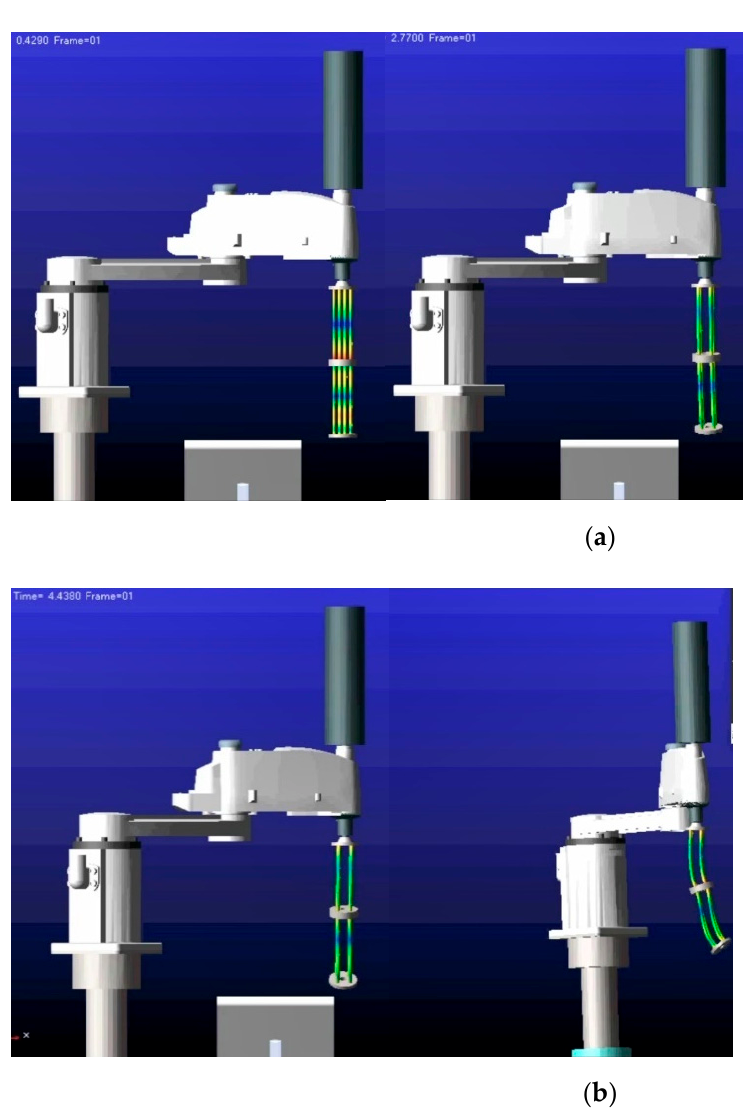
Figure 18. Cosimulation demonstration. ( a ) Cosimulation animation in T = 0.42 s and T = 2.76 s ; ( b ) cosimulation animation in T = 4.44 s and T = 5 s .